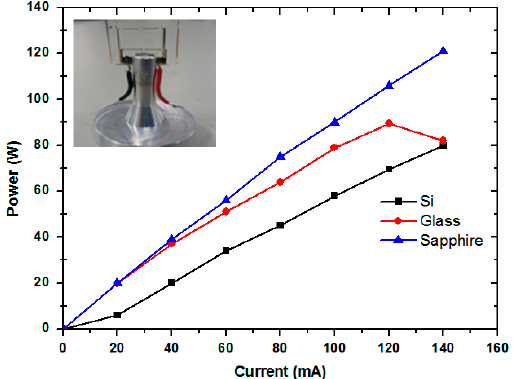
Figure 3. L–I curves for the different FCLED samples. The inset figure shows the transparent submount bidirectional LED module.